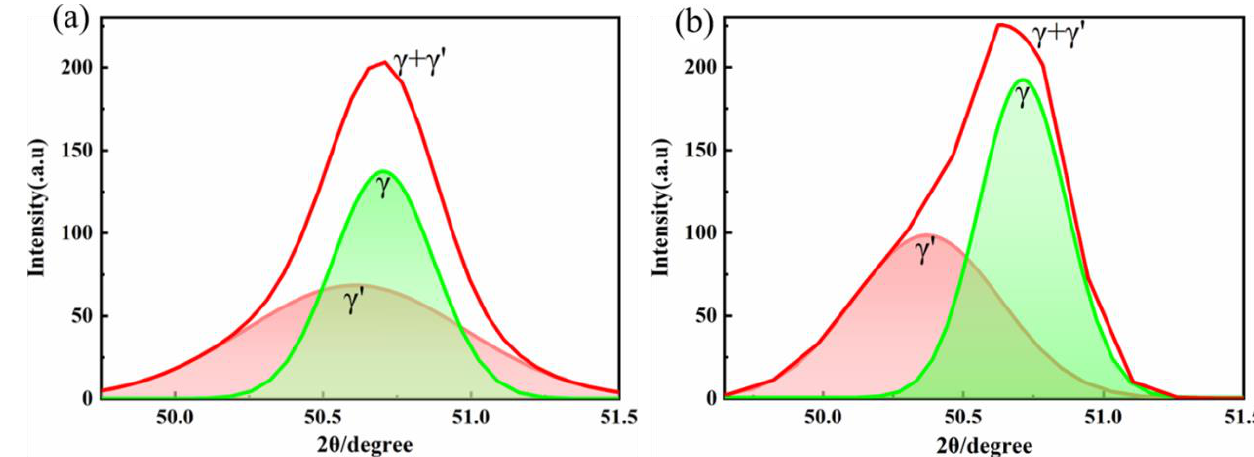
Figure 10. The (200) peaks of the XRD patterns for ( a ) 13Co and ( b ) 35Co with peak-fitted results with a Gaussian function.